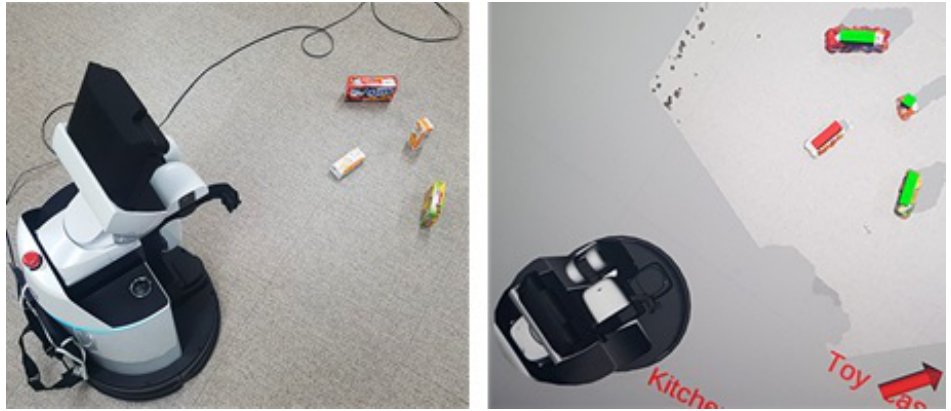
Figure 5. 3D pose estimation.